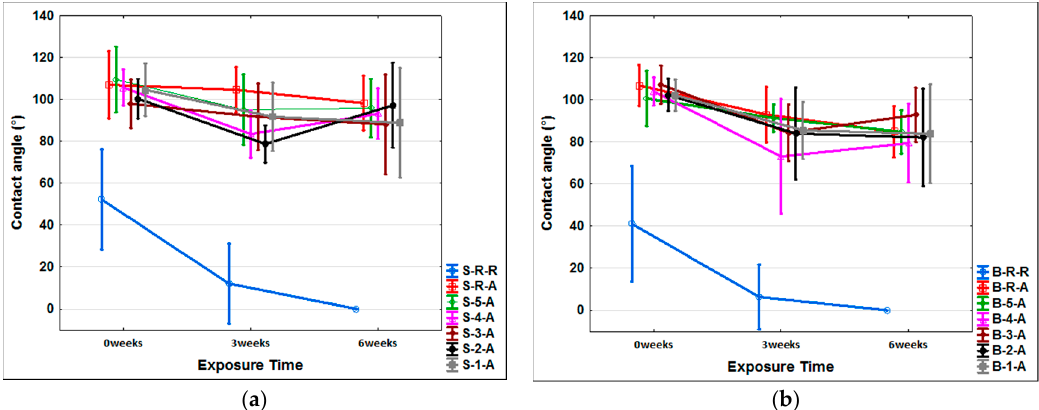
Figure 5. Water contact angle changes in tested wooden surfaces during AW: ( a ) Water contact angle (°) on tested spruce samples; ( b ) Water contact angle (°) on tested beech samples.